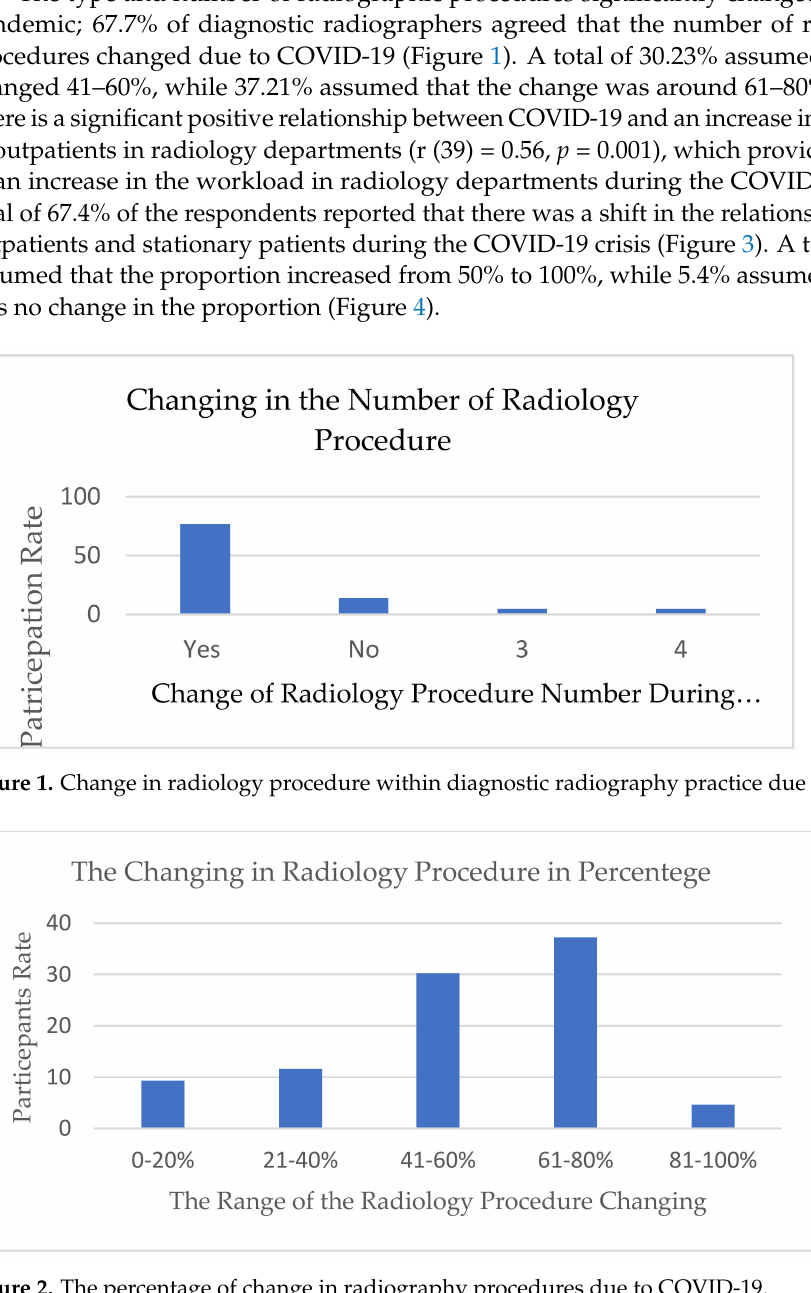
Figure 2. The percentage of change in radiography procedures due to